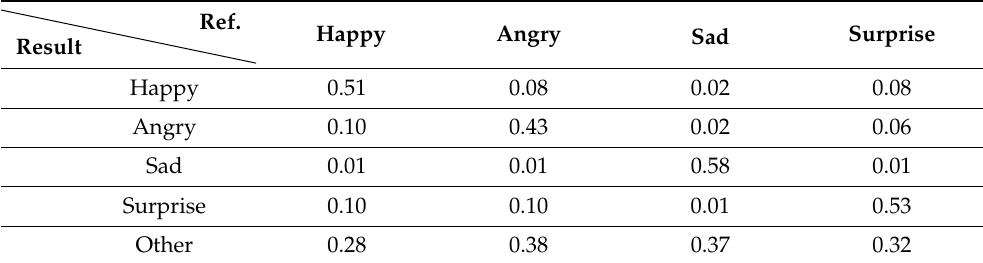
Table 5. Emotion recognition results.